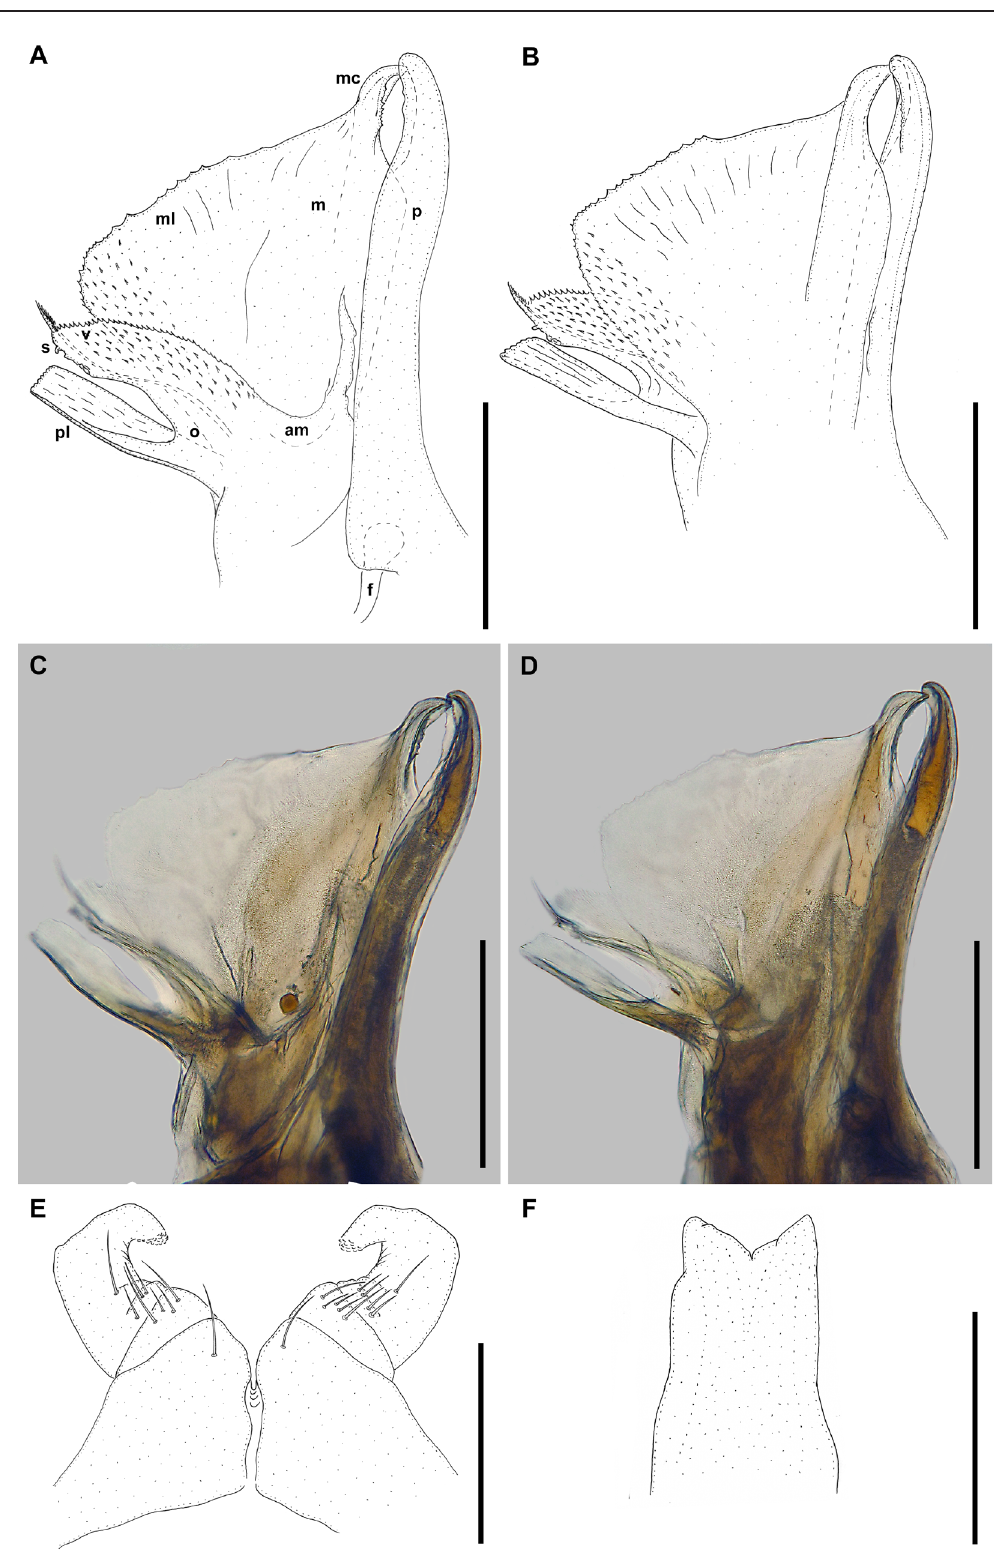
Fig. 46. Leucogeorgia redivivoides sp. nov., paratype ♂♂ from Nizhnyaya Shakuranskaya Cave (ZMUM). A . Right gonopods, mesal view. B . Left gonopods, lateral view. C . Right gonopods, mesal view. D . Left gonopods, lateral view. E . Leg-pair 1, anterior view. F . Penes, posterior view. Scale bars: 0.3